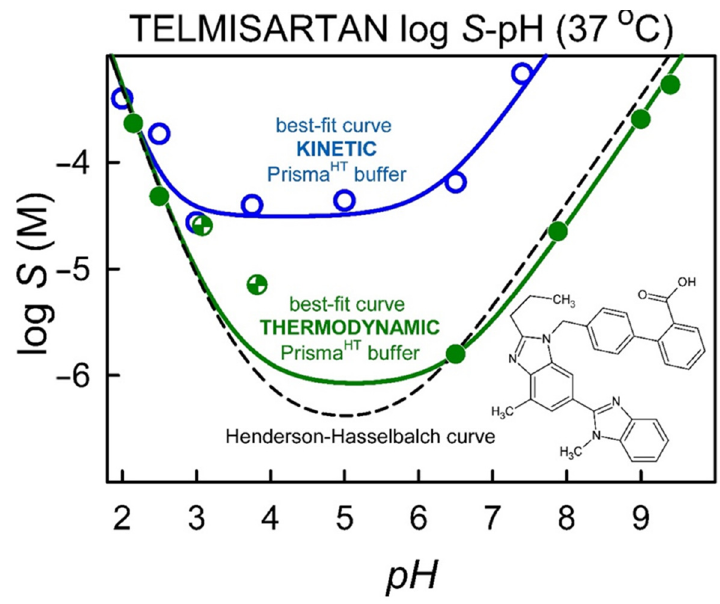
Figure 3. Thermodynamic and kinetic solubility-pH profile of Telmisartan in Prisma HT buffer at 37 °C.